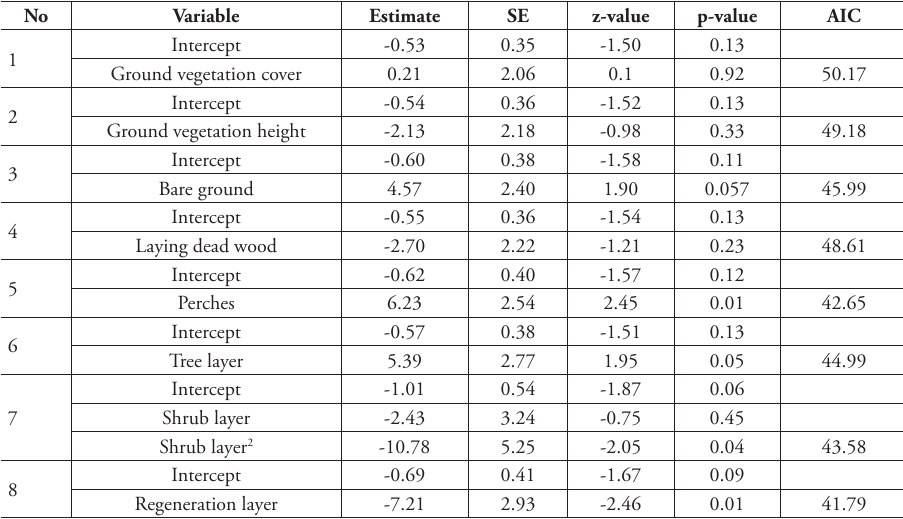
Table 2. Variables of the univariate approach with occupied/abandoned sites as binary response variable. For statistical details see material and